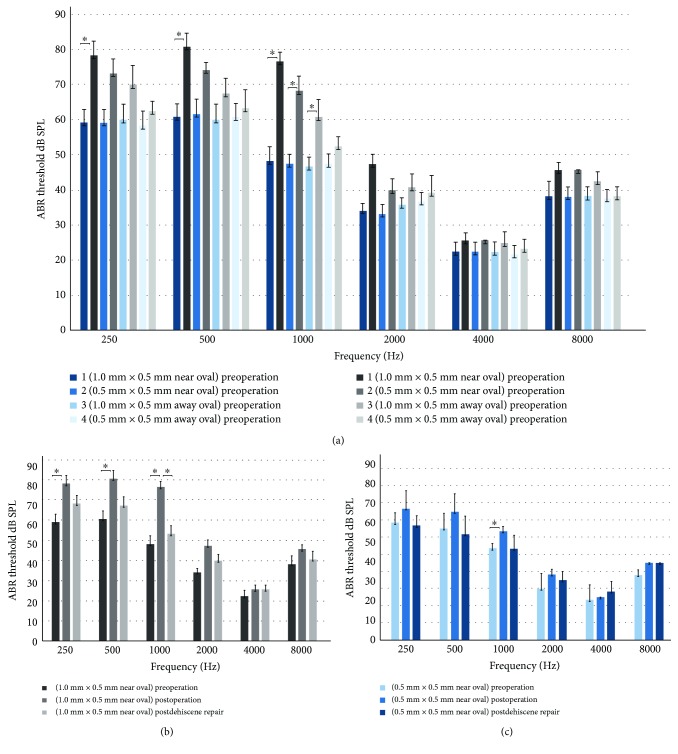
ABR threshold in different groups at frequencies of 0.25, 0.5, 1, 2, 4, and 8 kHz. (a) shows the ABR thresholds in four groups (1: 1 × 0.5 mm near the oval (n = 6), 2: 0.5 × 0.5 mm near the oval (n = 6), 3: 1 × 0.5 mm far away from the oval (n = 6), and 4: 0.5 × 0.5 mm far away from the oval (n = 6)) at frequencies of 0.25, 0.5, 1, 2, 4, and 8 kHz. ABR threshold in all frequencies increased after the dehiscence was created in group 1 and group 2, with a statistically significant difference at the frequency of 250, 500, and 1000 Hz (∗
P < 0.05) in group 1 (∗
P < 0.05) and 1000 Hz in group 2 (∗
P < 0.05). (b) and (c) show ABR threshold presurgery, postsurgery SSCD, and postdehiscence repair at frequencies of 0.25, 0.5, 1, 2, 4, and 8 kHz in groups 1 and 2. The ABR thresholds at the low frequencies 250, 500, 1000, and 2000 Hz increased notably after the dehiscence (1 × 0.5 mm near the oval and 0.5 × 0.5 mm near the oval) was created, with a statistically significant difference at the frequency of 250, 500, and 1000 Hz in group1 (∗
P < 0.05) and 1000 Hz in group 2 (∗
P < 0.05), which was offset after the dehiscence was repaired.